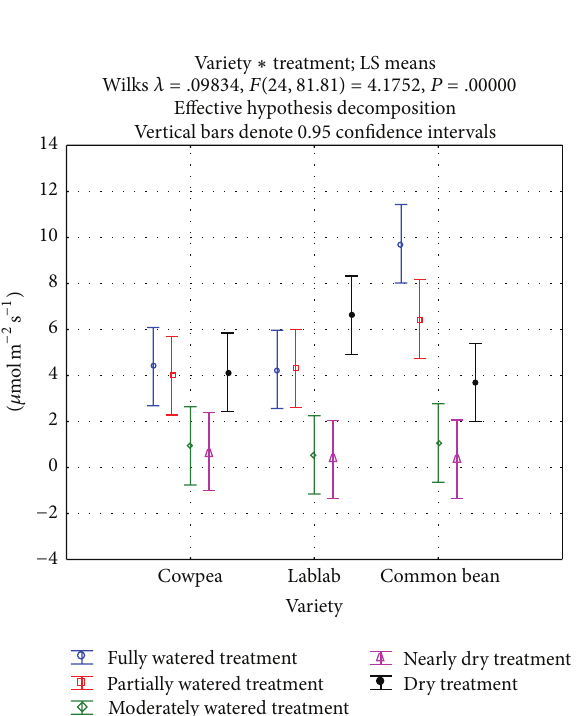
Current effect: F(6, 24) = 4.3627, P = .00409 Effective hypothesis decomposition Vertical bars denote 0.95 confidence intervals